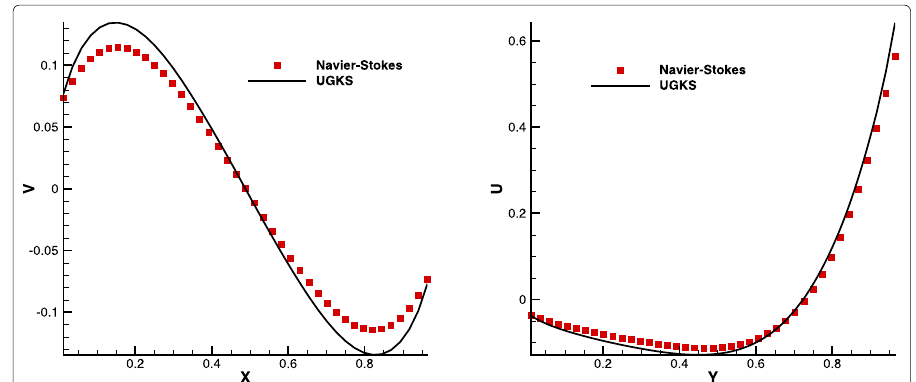
Fig. 19 The velocity distribution of the lid-driven cavity flow with Knudsen number 0.1. Left figure shows the y-directional velocity distribution along y = 0.5, and right figure shows the x-directional velocity distribution along x =